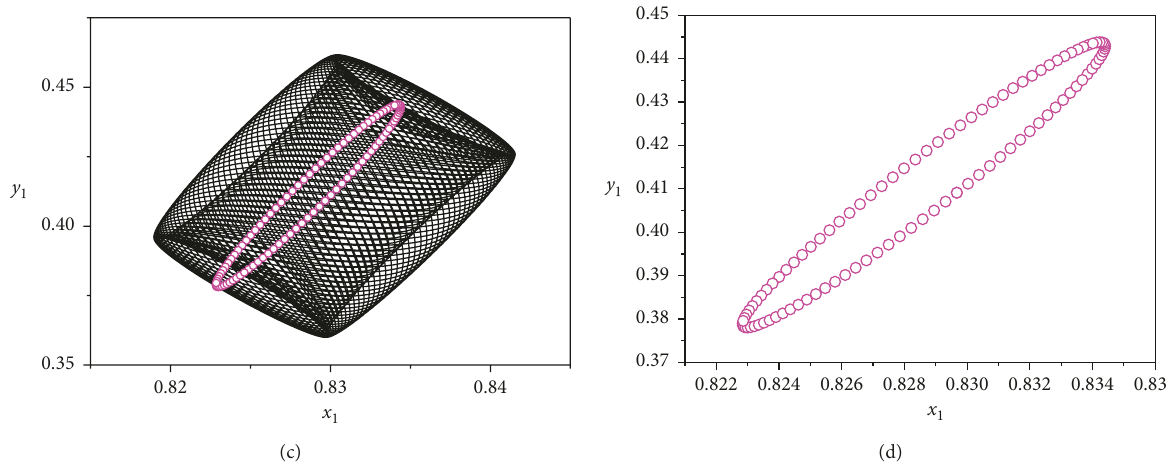
Figure 15: ω � 1.20 and η � 0.43: (a) displacement response; (b) frequency spectrum; (c) rotor orbit; (d) Poincar´e maps.